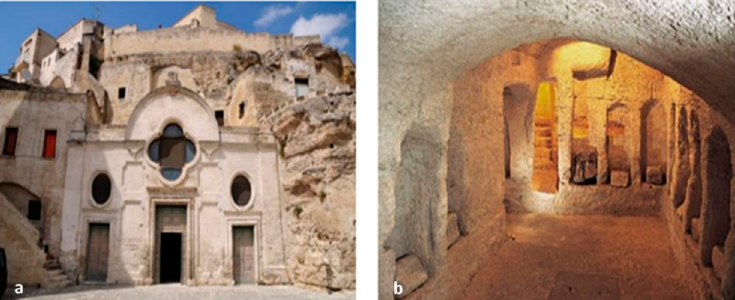
Figure 1. External facade ( a ) and hypogeum ( b ) of the San Pietro Barisano church.